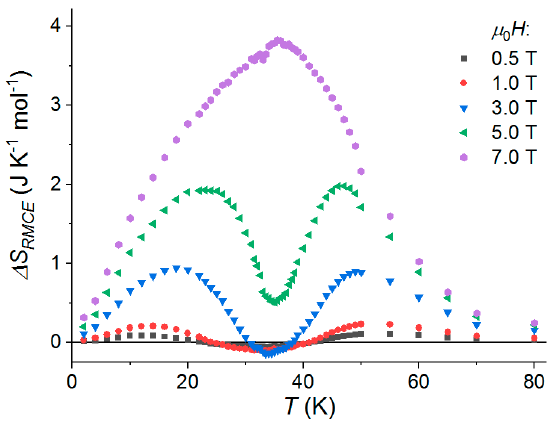
Figure 31. The magnetic entropy change for 11 due to application of the magnetic field 0- μ 0 H (black- easy plane, red -hard axis) and by rotating the crystals in constant field μ 0 H . ( a ) μ 0 H = 7.0 T, ( b ) μ 0 H = 1.0 T.